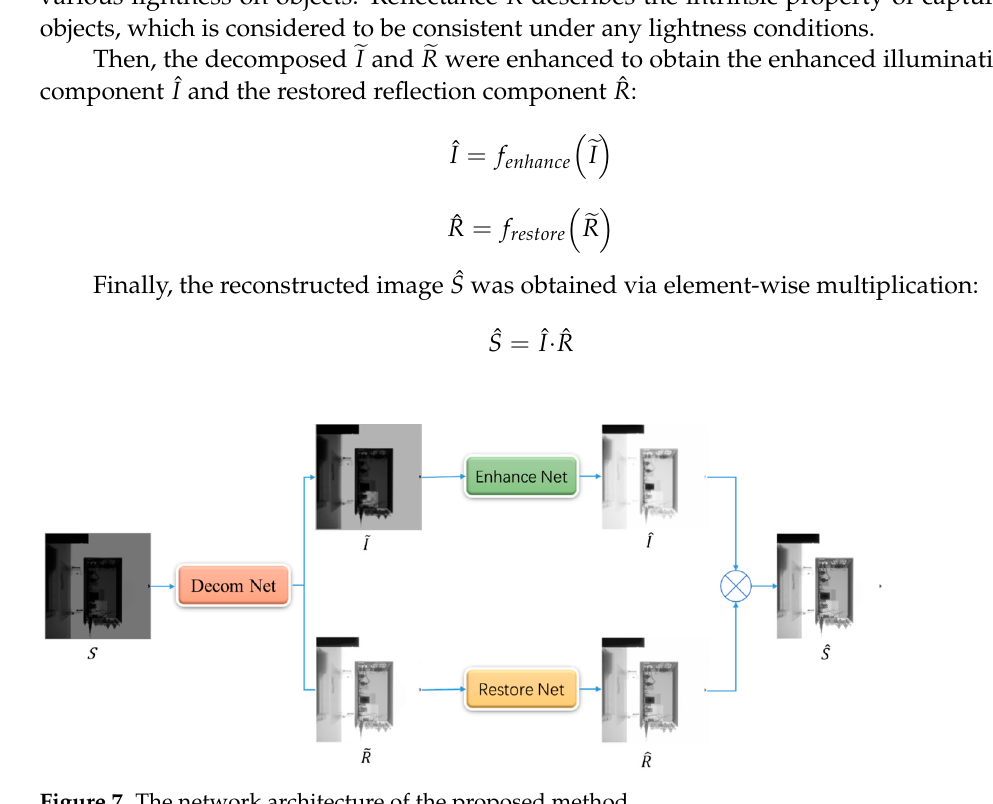
Figure 7. The network architecture of the proposed